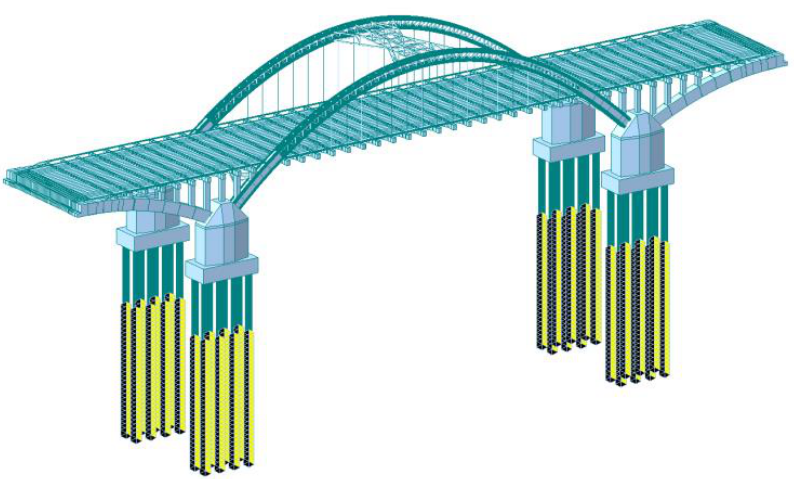
Figure 3. FE model of the third Lingjiang bridge.